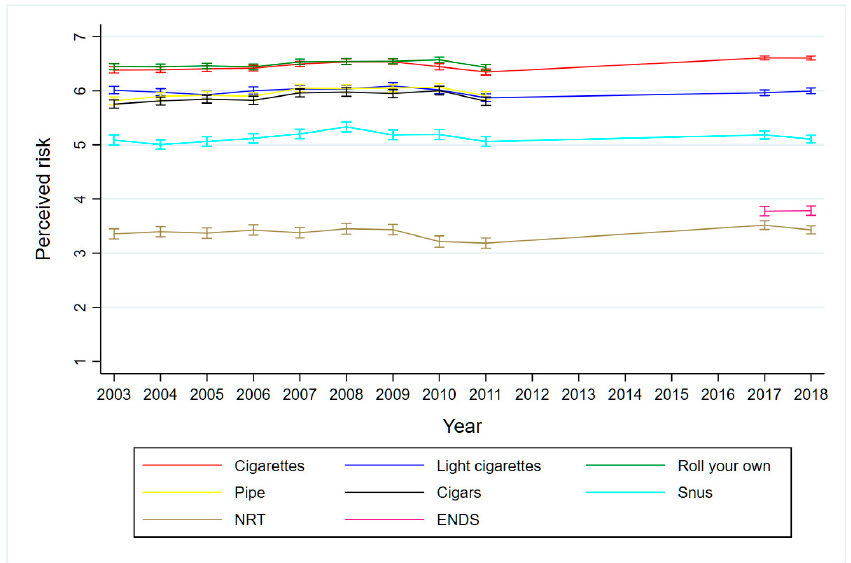
Figure 2. Perception of the harmfulness of eight nicotine products among Norwegian adults ages 16–79 years, 2003–2018. Unadjusted mean risk scores on a scale from 1 (slightly harmful) to 7 (very harmful).